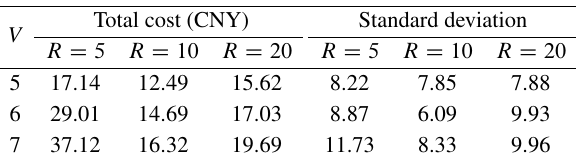
Table 6 Total cost when V and R